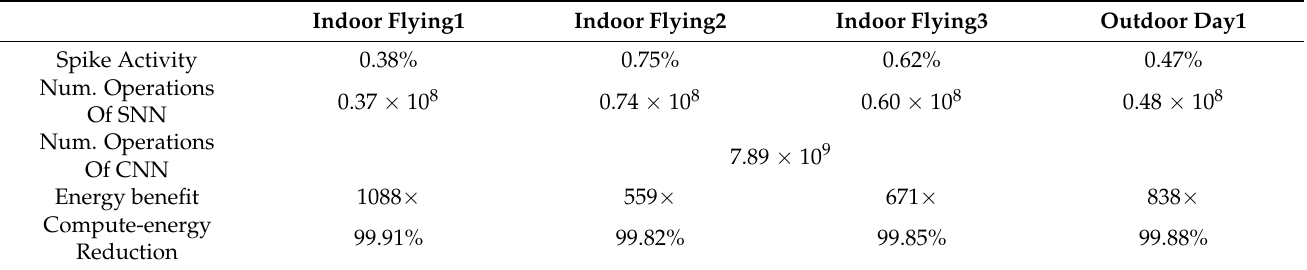
Table 2. Analysis for operations and overall computational energy benefits compared with CNN.